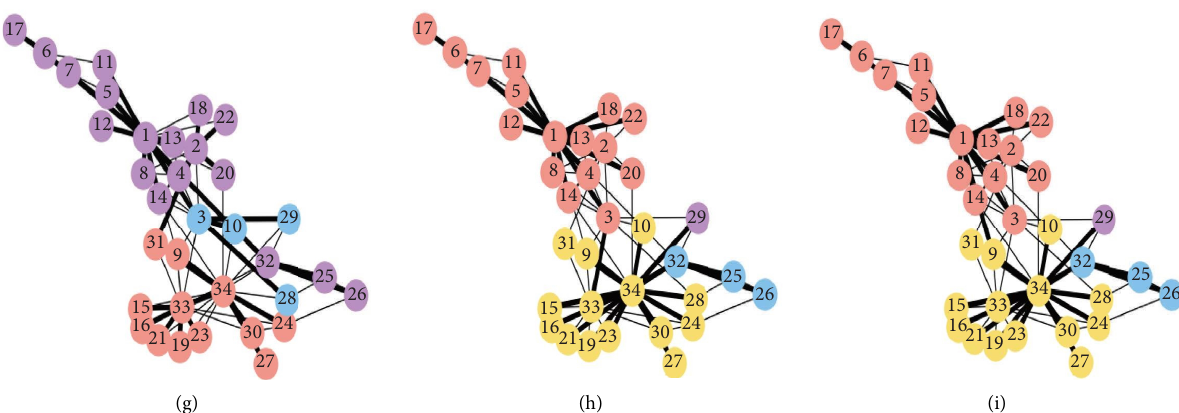
Figure 7: Tis fgure illustrates the impact of diferent similarity measures on the resultant MSTtree and the fnal partition of the algorithm over the Zachary karate club dataset. (a) Common neighbors, (b) Jaccard, (c) Cosine, (d) HPI, (e) Adamic/Adar, (f) RA, (g) CNDP, (h) SRW, and (i) HIN.